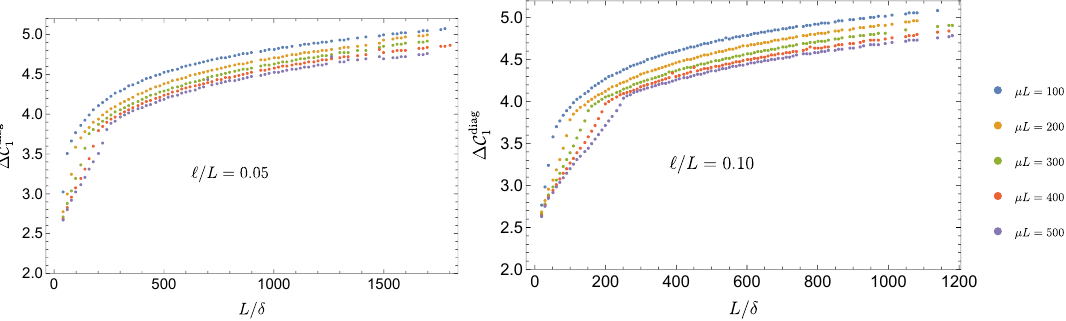
Figure 17 . Subregion size dependence of the mutual complexity in the diagonal basis (cid:1) C diag di(cid:11)erent reference frequencies (cid:22)L = 100, 200 and 300. The cuto(cid:11) was set to (cid:14)=L = 1 =N = 1 = 1000 and the mass to mL = 0 : 01.